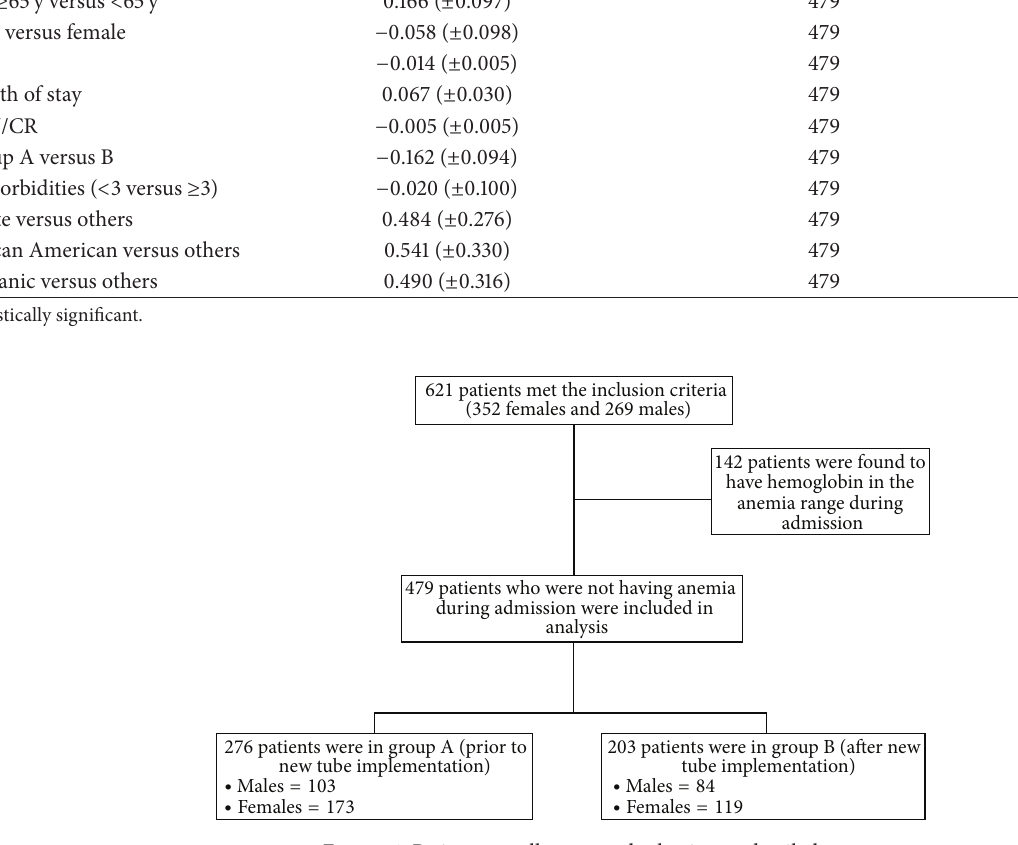
Figure 1: Patients enrollments and